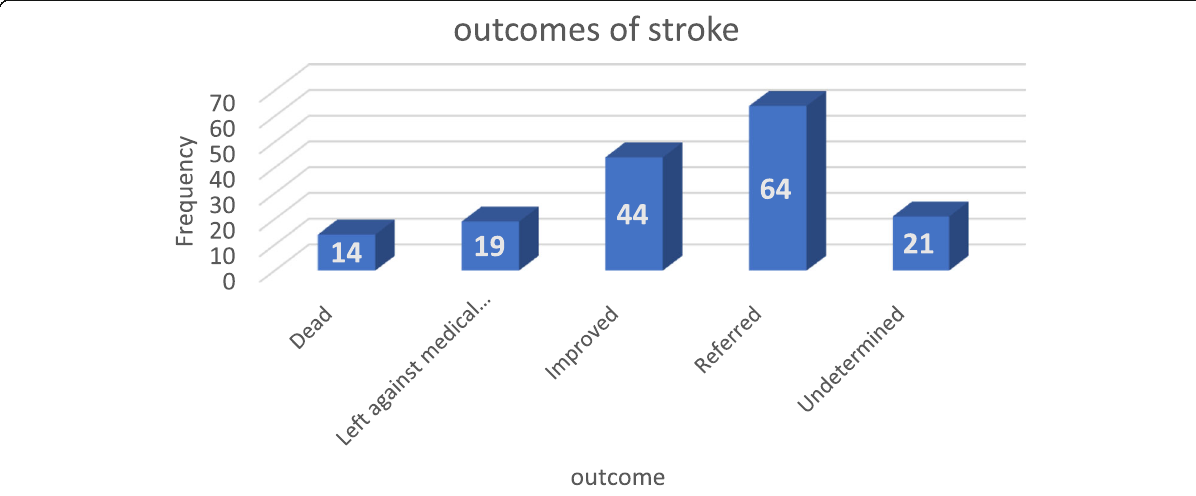
Fig. 2 Prognostic outcomes of stroke in the medical ward of Debre Markos Referral Hospital, Northwest Ethiopia, 2017 –